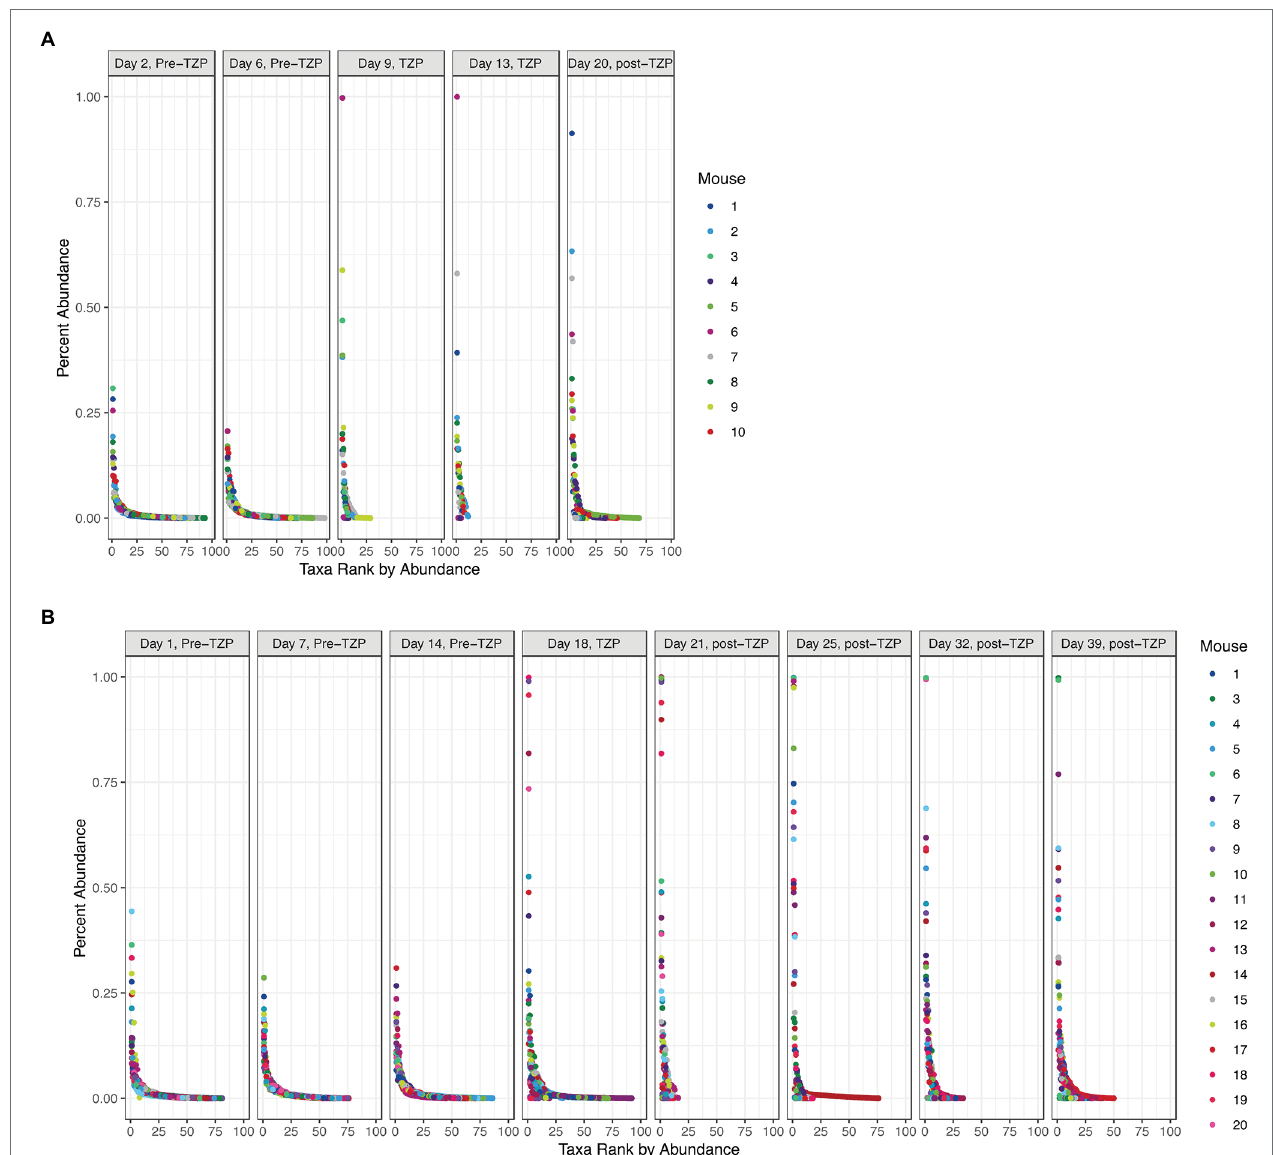
FIGURE 4 | Bacterial community structure. The OTUs for all mice in each experiment (TZP1 in A , TZP2 in B ) are plotted by ranked abundance for each time